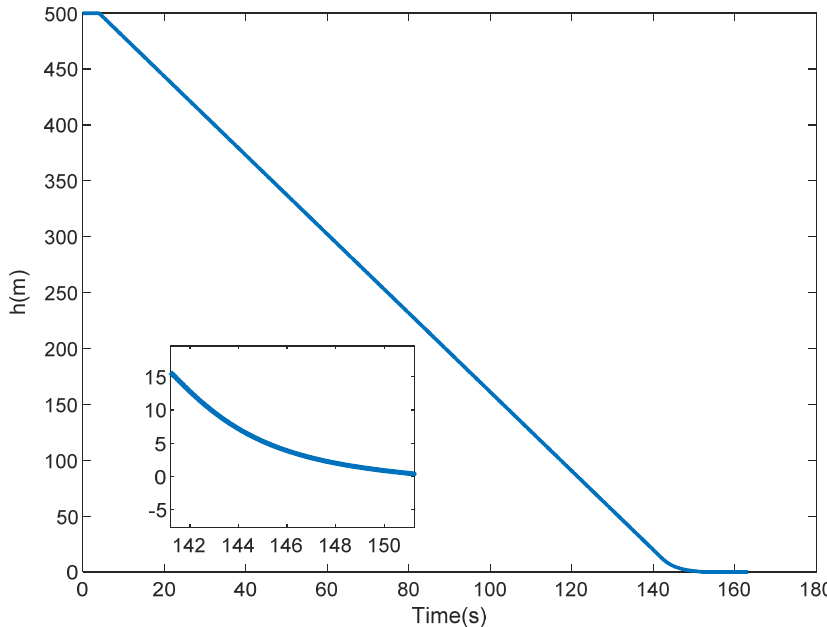
Figure 2. The desired trajectory of the altitude.